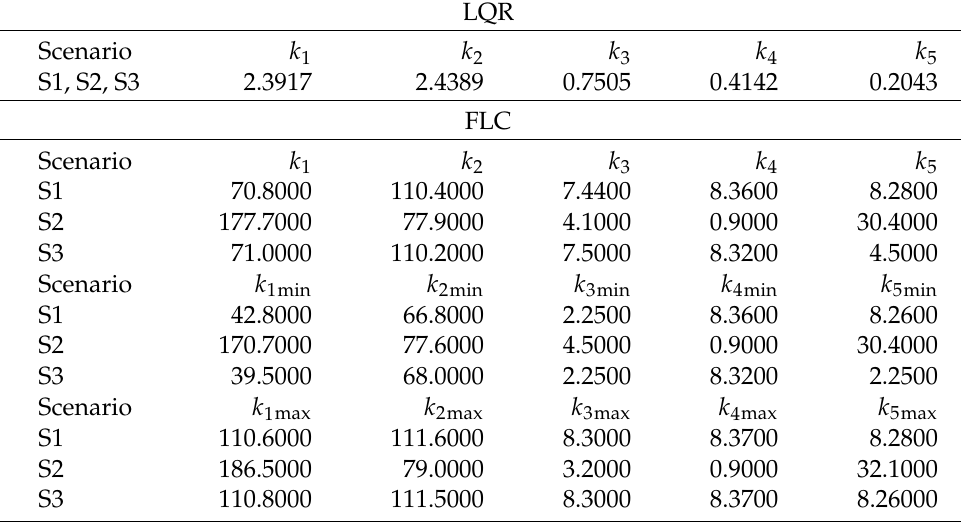
Table 4. Controller gains, Area 2.